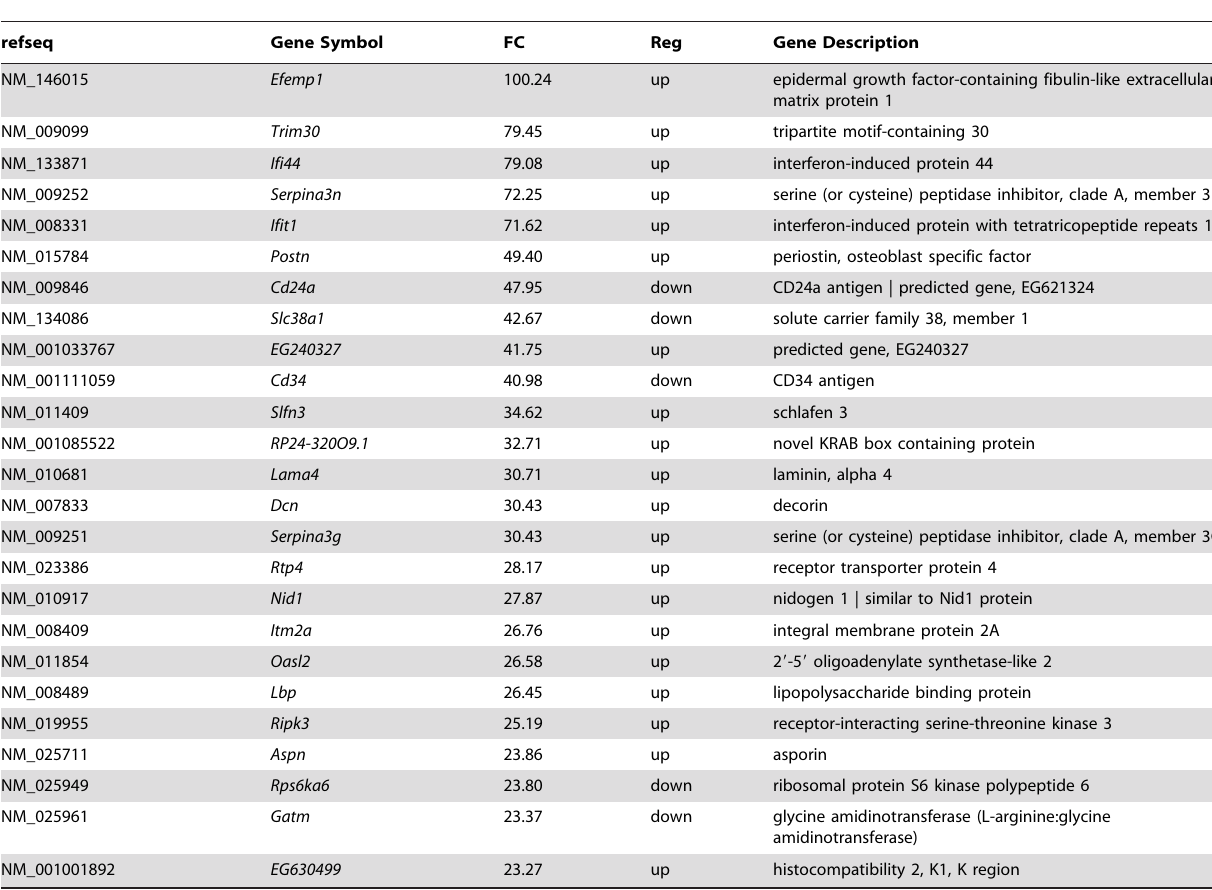
Table 1. Top 25 differentially expressed Affymetrix Mouse Exon 1.0 St Array probe sets in MEFs between the wild type and Mta1 knock